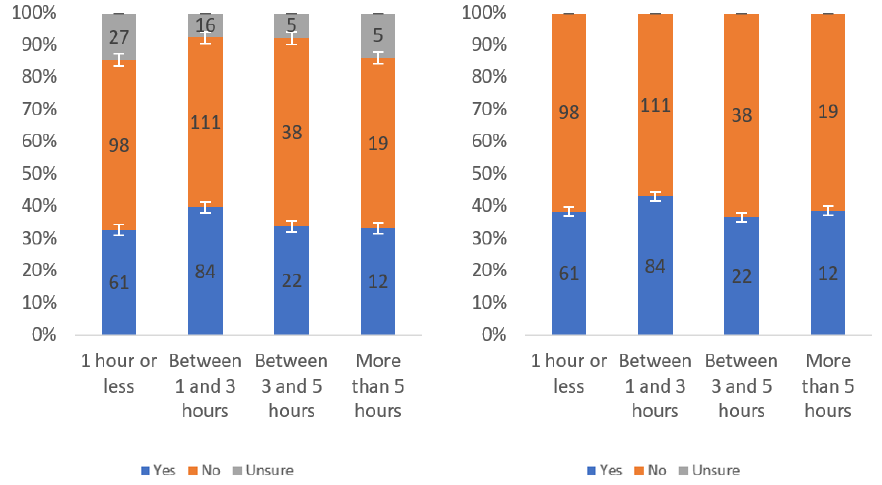
Figure 28. Responses regarding label annoyingness by internet usage level including ( left ) and excluding ( right ) unsure responses.